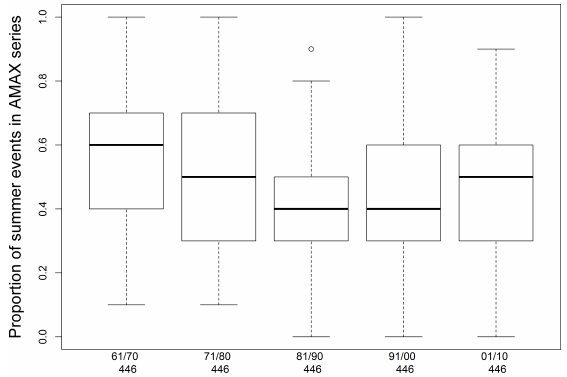
Fig. 4. Proportion of summer events in the annual maximum rainfall series, shown separately for each decade. The number of catchments used to compute the proportions is indicated below the x